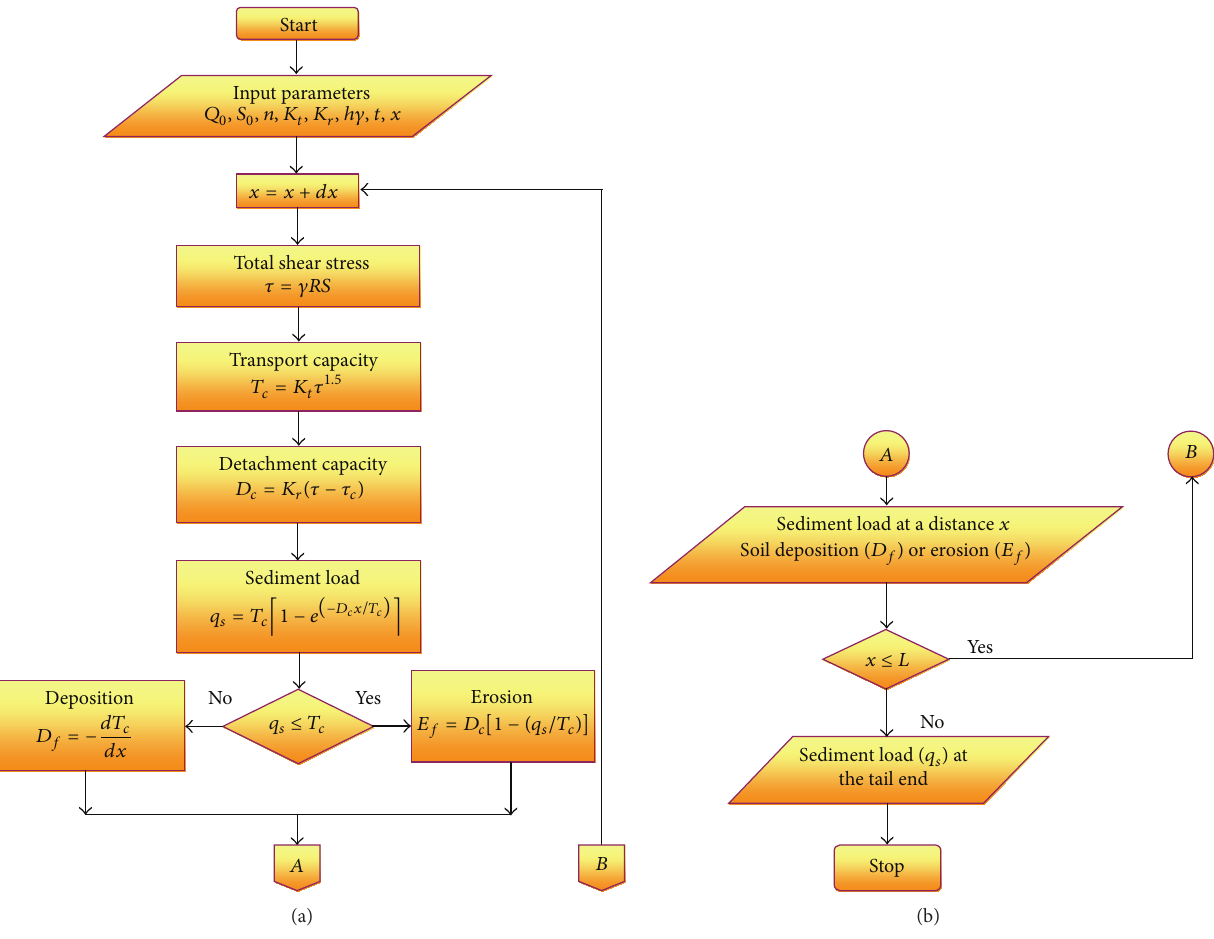
Figure 1: Flowchart showing the working of sediment transport